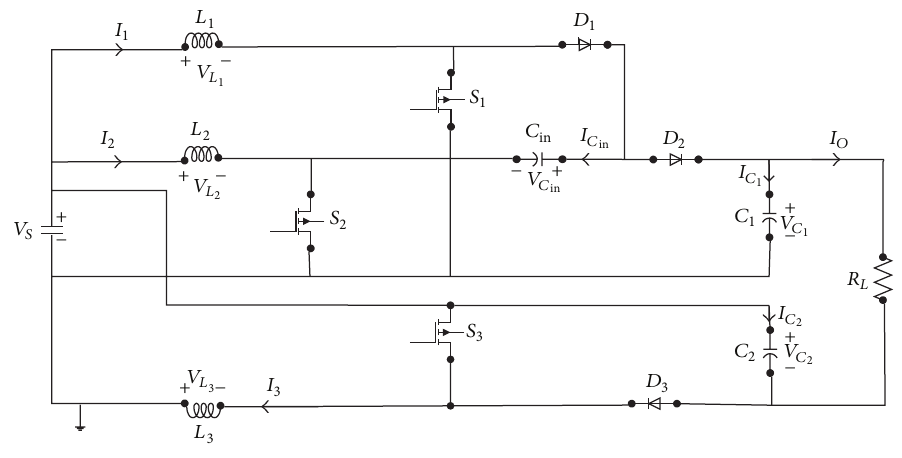
Figure 2: Circuit diagram of the proposed